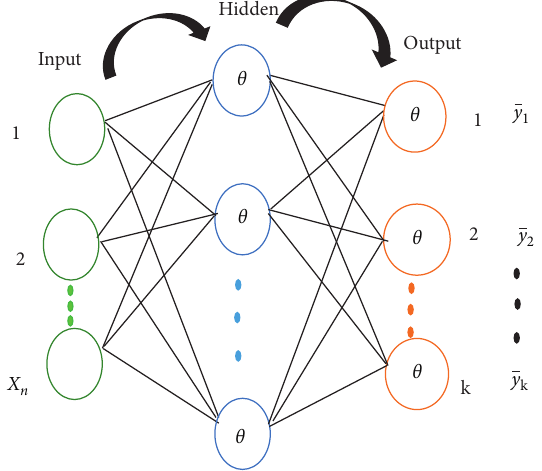
Figure 1: Neural network